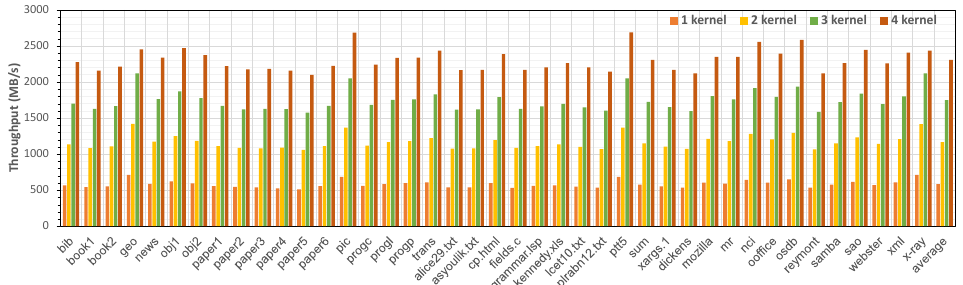
Figure 8. The end-to-end throughput performance of the HybriDC system with different number of compression kernels evaluated by the Calgary corpus, the Canterbury corpus, and the Silesia